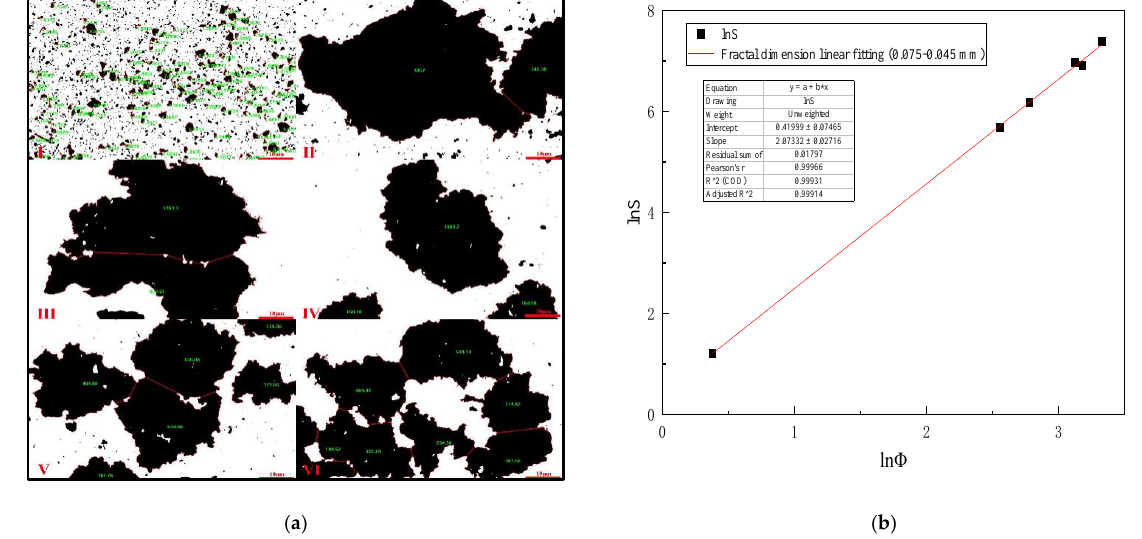
Figure 10. ( a ) Area diagram of 0.075–0.045 mm coal slime floc at different mixing speeds. ( I ) 0, ( II ) 200 r/min, ( III ) 400 r/min, ( IV ) 600 r/min, ( V ) 800 r/min, ( VI ) 1000 r/min; ( b ) Fractal dimension fitting diagram of settling floc of 0.075–0.045 mm coal slime. 4.6. Mixing Speed versus Equivalent Diameter of Settling Floc ( − 0.045 mm Slime) Table 10 is analyzed by Image-Pro-Plus 6.0 software and (Formulas (15) – (17)), which shows that when the mixing speed is 400 r/min, the equivalent diameter of − 0.045 mm slime settling floc is the largest, and the settling speed of slime floc is the fastest on the microscopic level. Figure 11a is the analysis diagram of floc area of − 0.045 mm slime at the mixing speed of 0 – 1000 r/min. Figure 11b shows the fractal dimension fitting diagram, when the mixing speed is 0 – 1000 r/min, the mean fractal dimension of − 0.045 mm coal slime floc is 1.940. Table 10. Mixing speed versus equivalent diameter of settling floc ( − 0.045 mm slime).